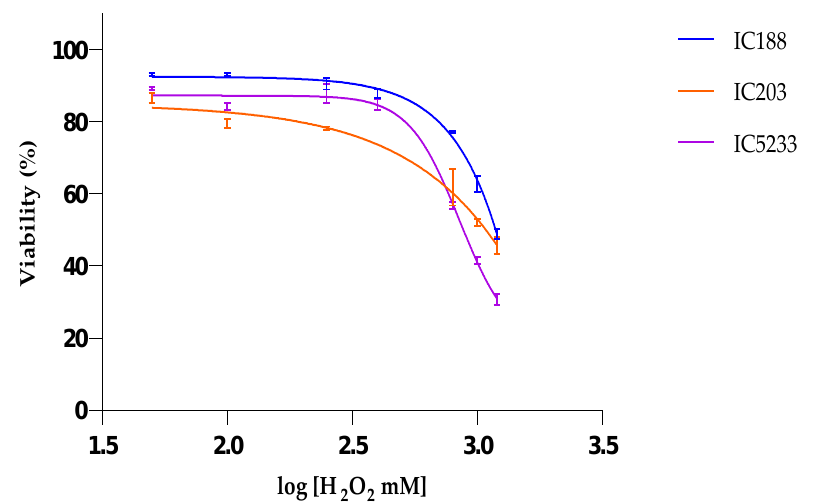
Figure 4. Flow cytometric assay of H 2 O 2 cytotoxicity to E. coli strains IC188, IC203 and IC5233. The curves represent the % of live cells versus the logarithm of the concentration. Results are mean ± SD (n = 3).